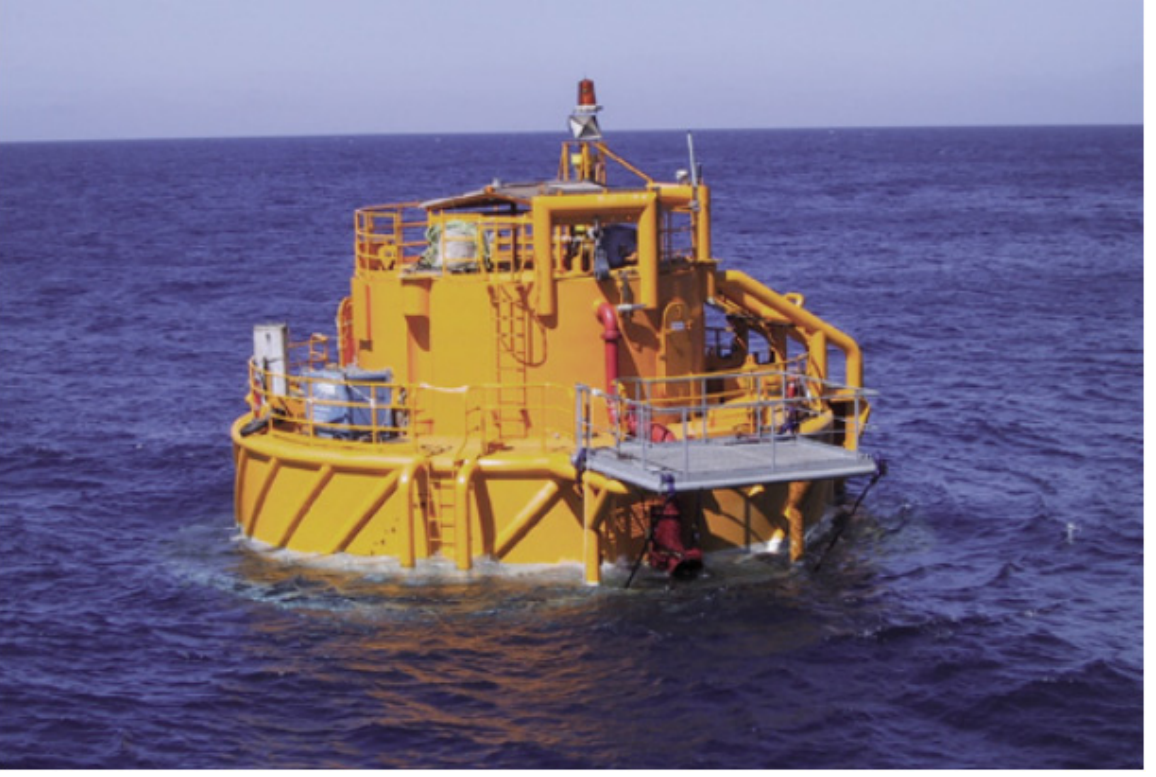
Figure 1. CALM Turret buoy at Apache Stag Field, Australia, Buoy during installation (Reprinted with permission from ref. [49]. Copyright 2011